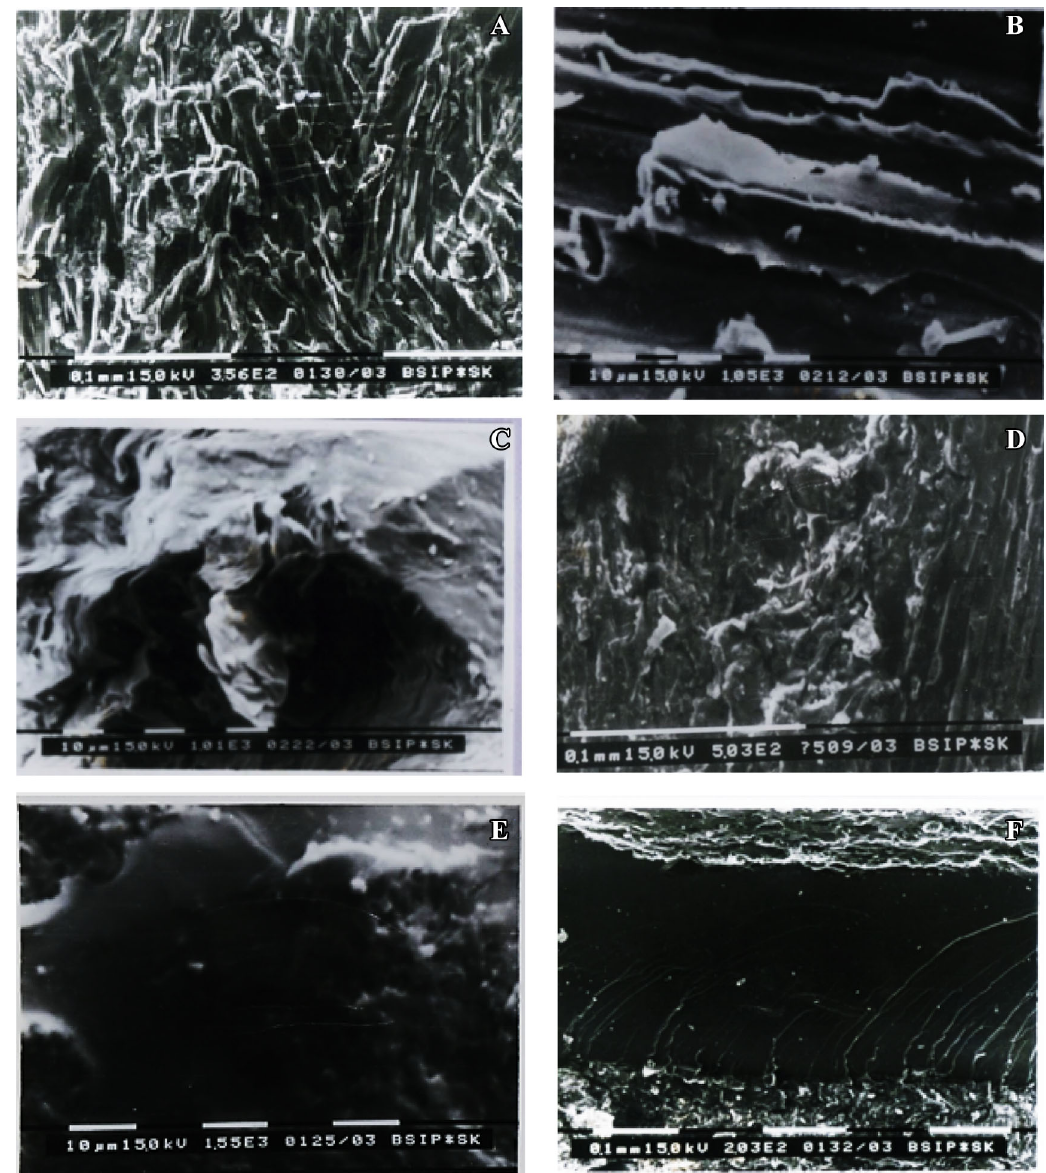
Fig. 3 SEM photomicrographs a – d showing vitrain band from Umaria and Ib valley with superficial mounting, mineral impregnation, cavity filling and mineral matter filling in tracheids. SEM photomicrographs e , f showing clarain band from the same coalfield with mineral intergrowth, deep impregnation and superficial mounting of mineral matter dominantly of argillaceous siliceous and sideritic